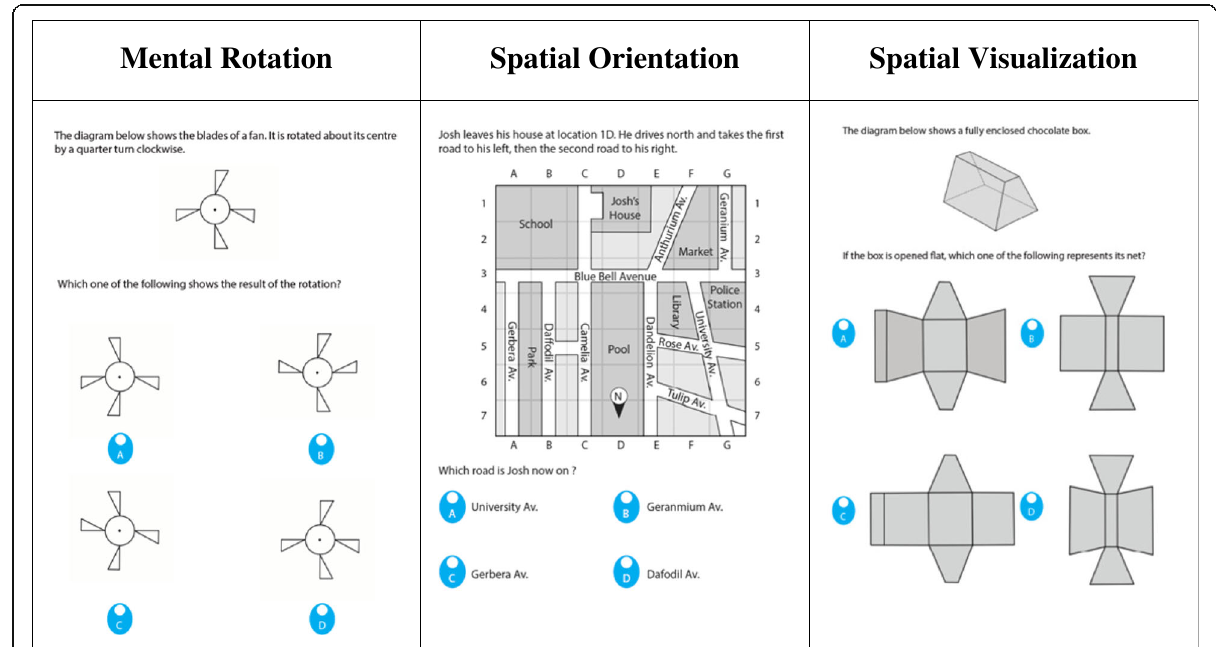
Fig. 1 Sample items from the SRI (Ramful et al., 2017)